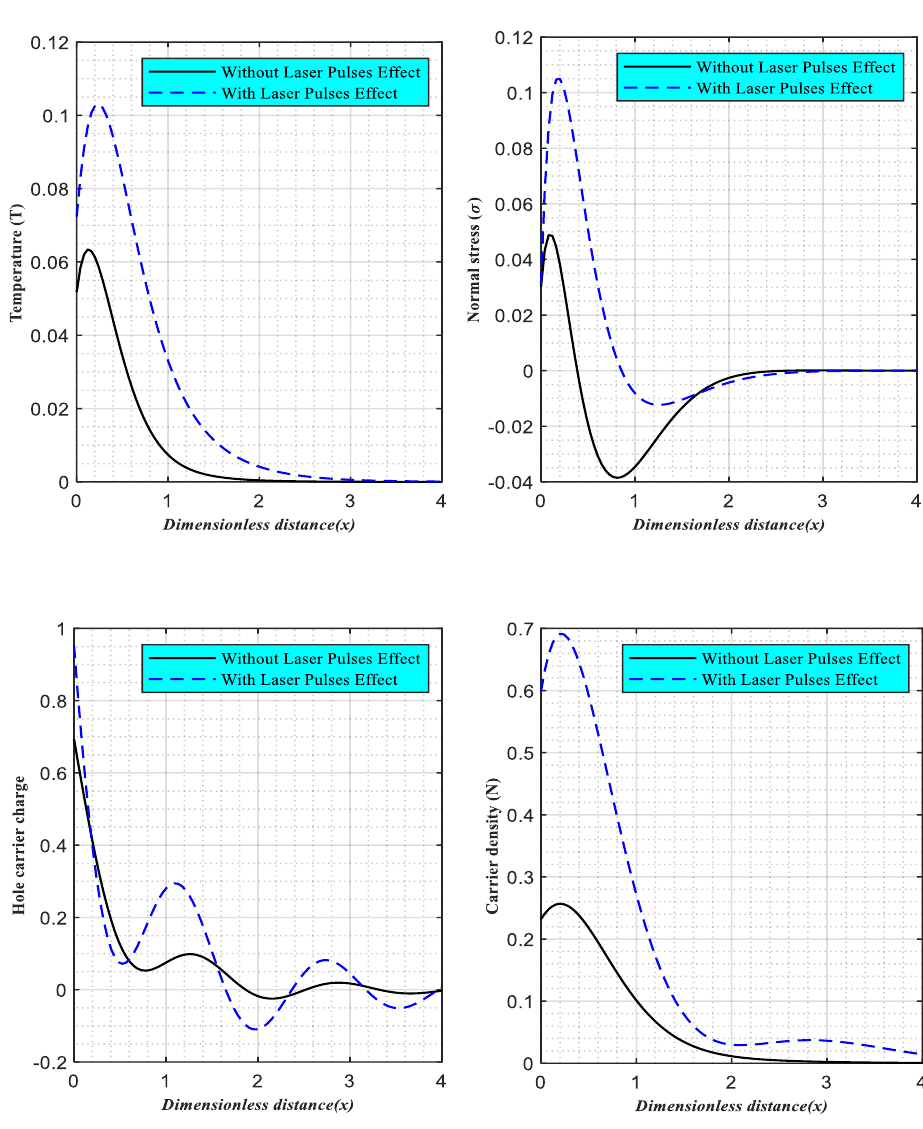
Figure 5. The dependence on distance of the principal field distributions induced by laser pulses in the DPL model with Hall current is